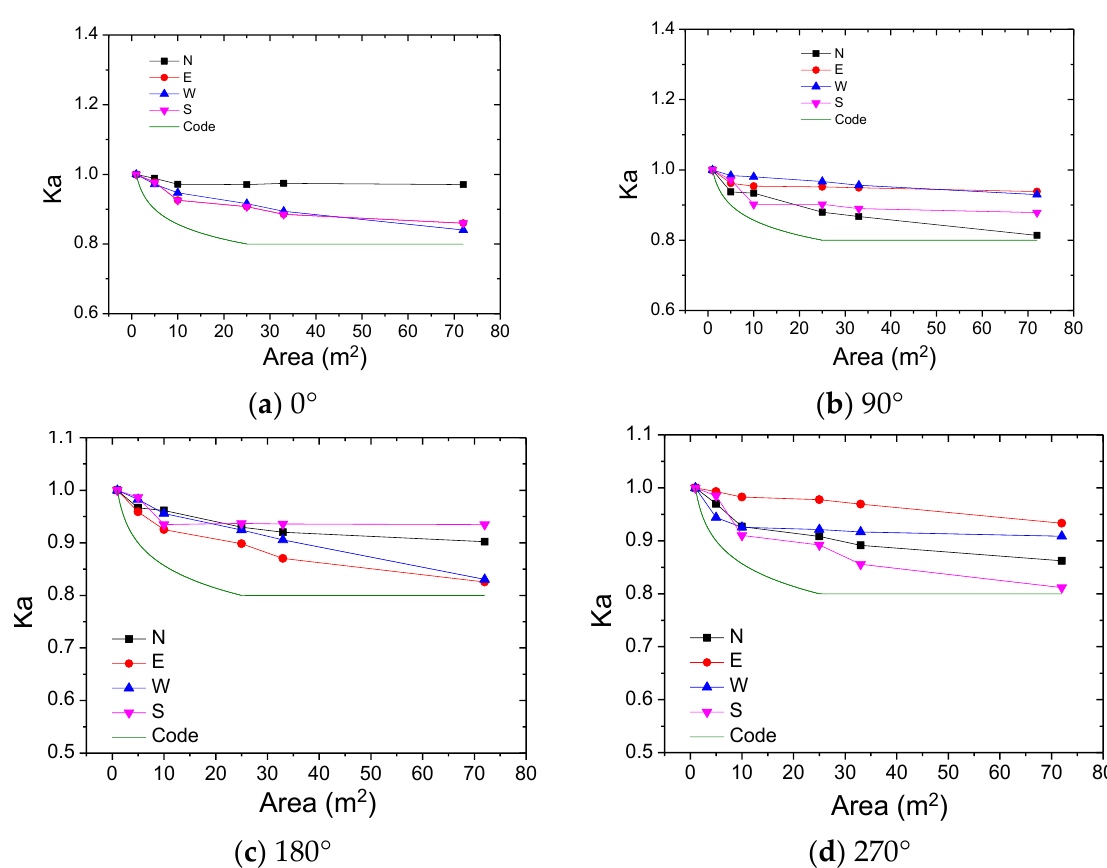
Figure 12. The area reduction factors of different area sizes of each facade: ( a ) 0°, ( b ) 90°, ( c ) 180°, ( d ) 270°. The area reduction factors for the extreme pressure coefficient gradually decrease as the average-areas increase. The results from the comparison show that the reduction effect of the extreme wind pressure is smaller than the area reduction effect of the mean wind pressure. According to GB50009, the extreme wind effect will be underestimated by considering the area reduction of the design wind load of the cladding. Figure 13 shows the scatter diagram of the area reduction factor of the area-averaged extreme pressure coefficients with areas of 5 m 2 ,10 m 2 , and 25 m 2 under different wind direction angles. As can be seen from Figure 13, when the subordinate area is 5 m 2 ,10 m 2 , and 25 m 2 , the extreme wind pressure area reduction factor is in the range of 0.93–0.99, 0.88–0.98, and 0.85–0.97; the mean value of the area reduction factor is 0.97, 0.95, and 0.93; and the COV is 0.02, 0.03, and 0.04. The normal probability distribution is used to fit the area reduction factor K a of the extreme pressure coefficient. Figure 14 shows the probability plot of the normal distribution of the K a value. The results shown in Figure 14 indicate that the normal distribution is suggested for the probability distribution fitting of the area reduction factor